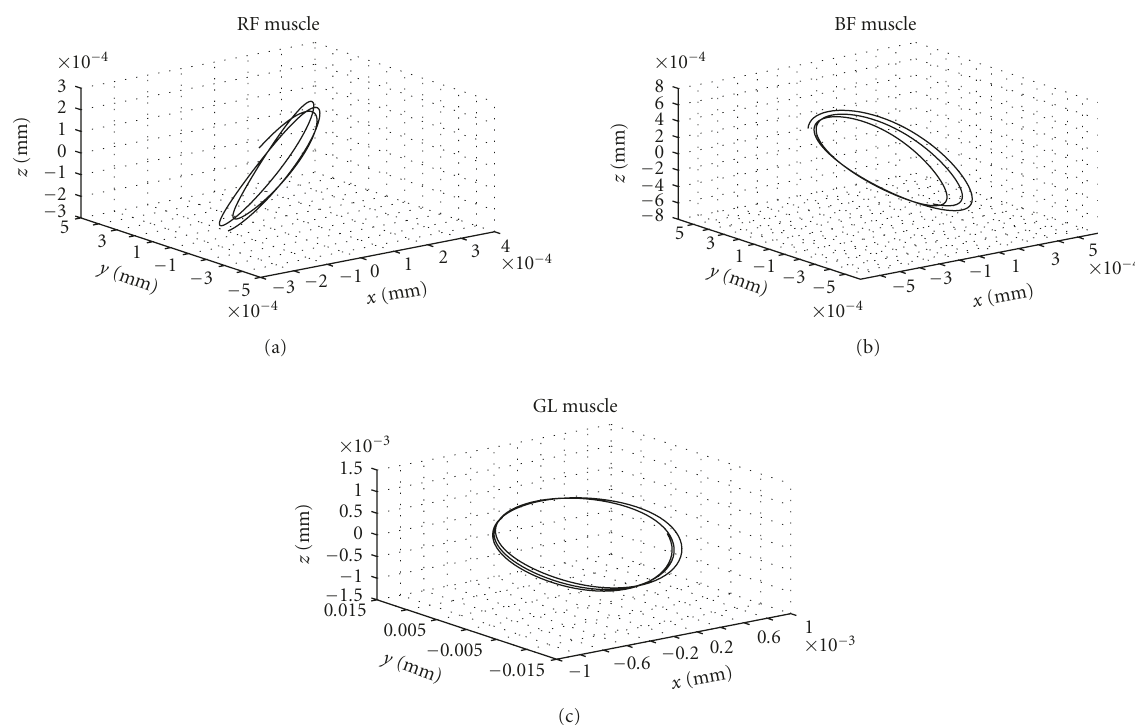
Figure 4: An example of three dimensional displacement of RF, BF and GL muscle belly under vibratory stimulation. The subject was holding the hack squat position while the frequency of the vibratory stimulus was around to 24Hz. The figure depicts few cycles. The reference position for each muscle was placed at the accelerometer